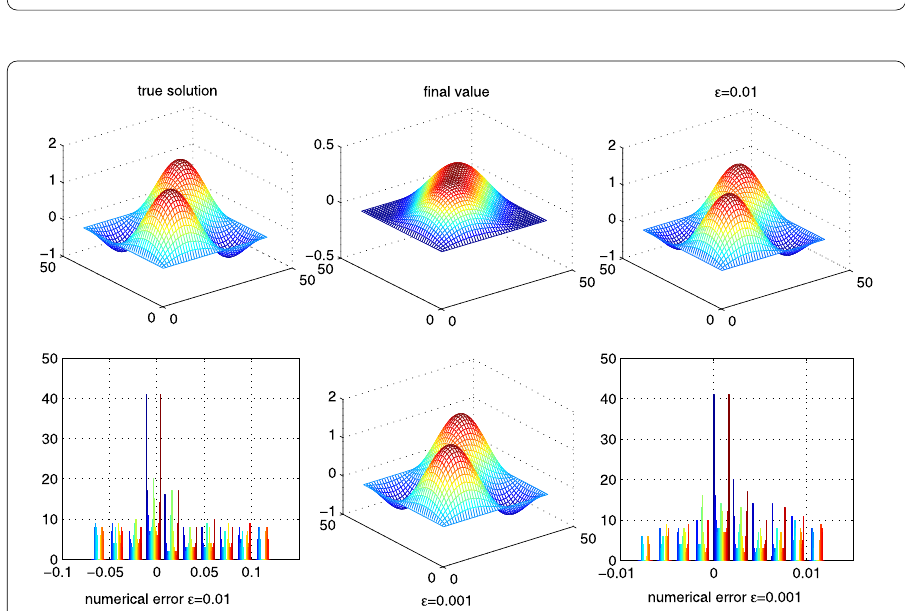
Figure 5 The comparison of numerical effects between the exact solution and its regularized solution for Example